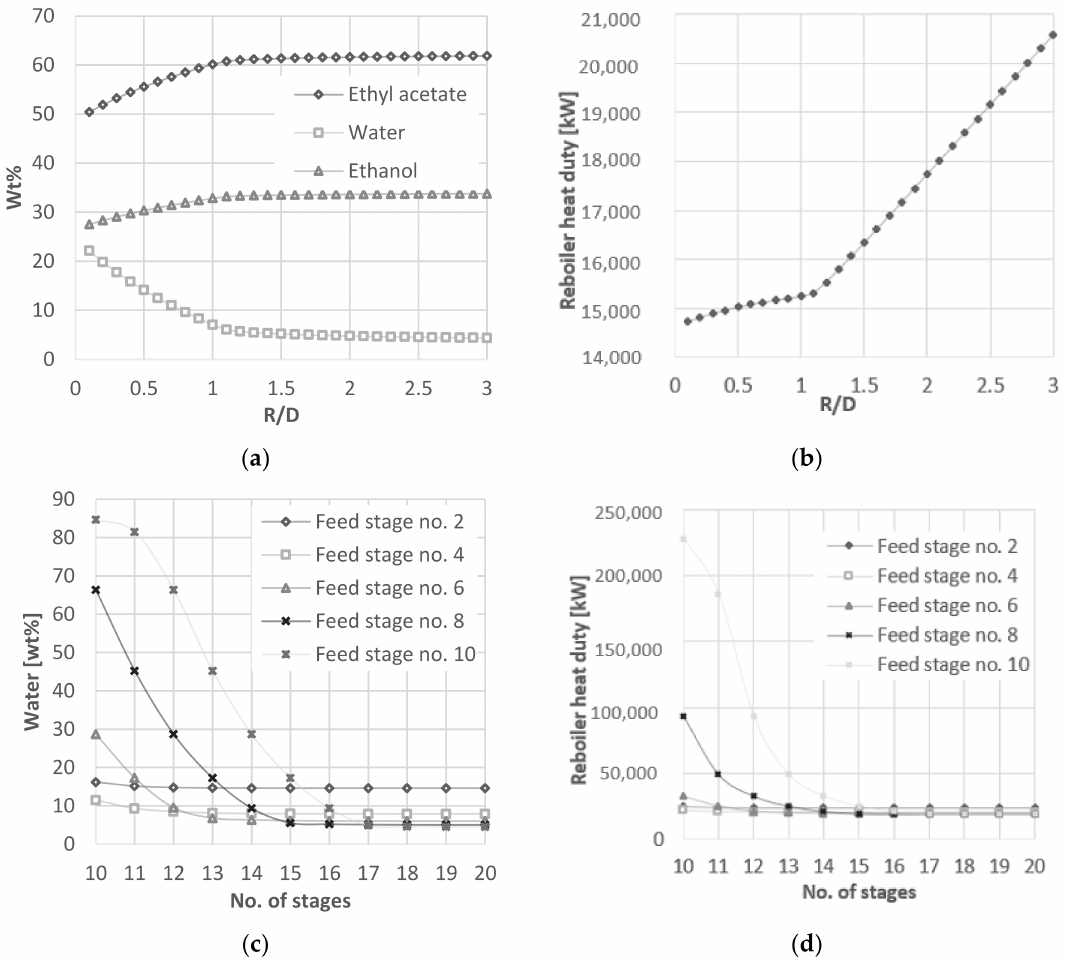
Figure 7. The influence of R/D ratio on: ( a ) the content of EA, water and ethanol in the distillate of the wastewater column; ( b ) reboiler duty. The influence of column feeding place and the number of stages on: ( c ) water content in distillate; ( d ) reboiler